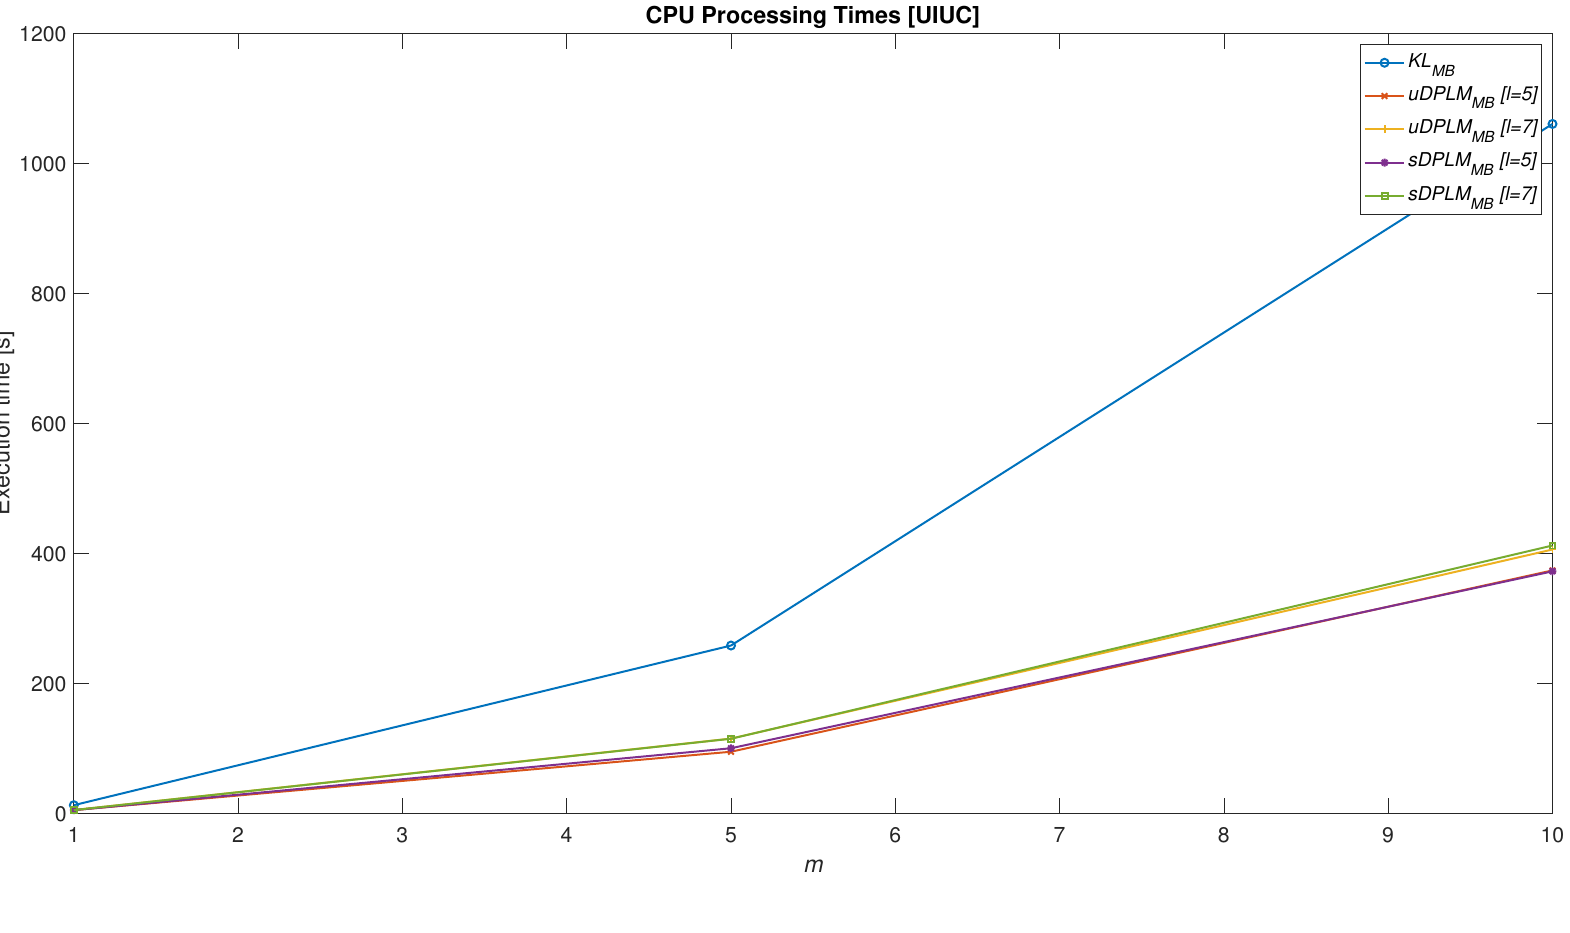
Figure 3. CPU processing times for the UIUC database, DPLM MB vs. KL MB